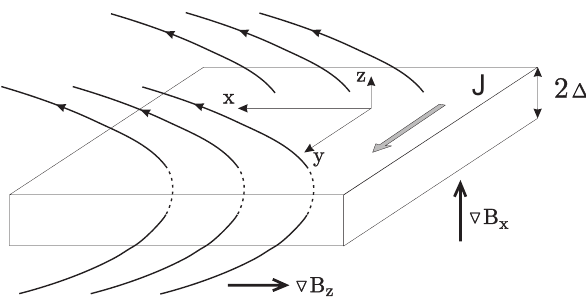
Fig. 2. Geometrical situation of the problem. Background configu-